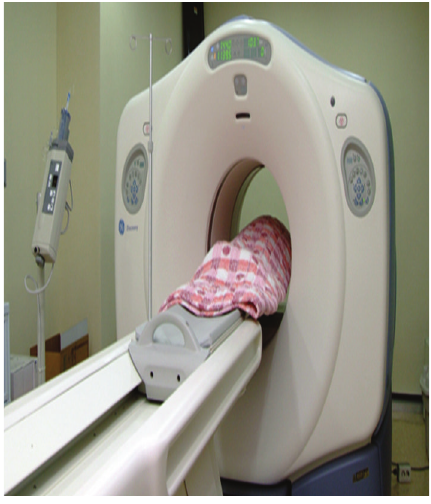
Figure 3: PET/CT scanner (Discovery VCT, GE Milwaukee,